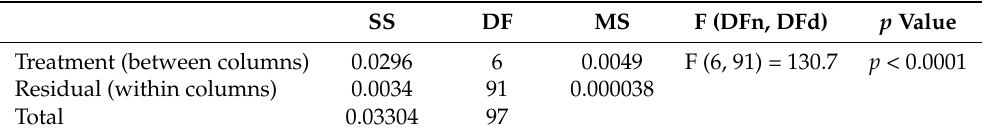
Table 8. The results of the analysis-of-variance (ANOVA) test for evaluating the proposed feature selection algorithm, bPSOBER.